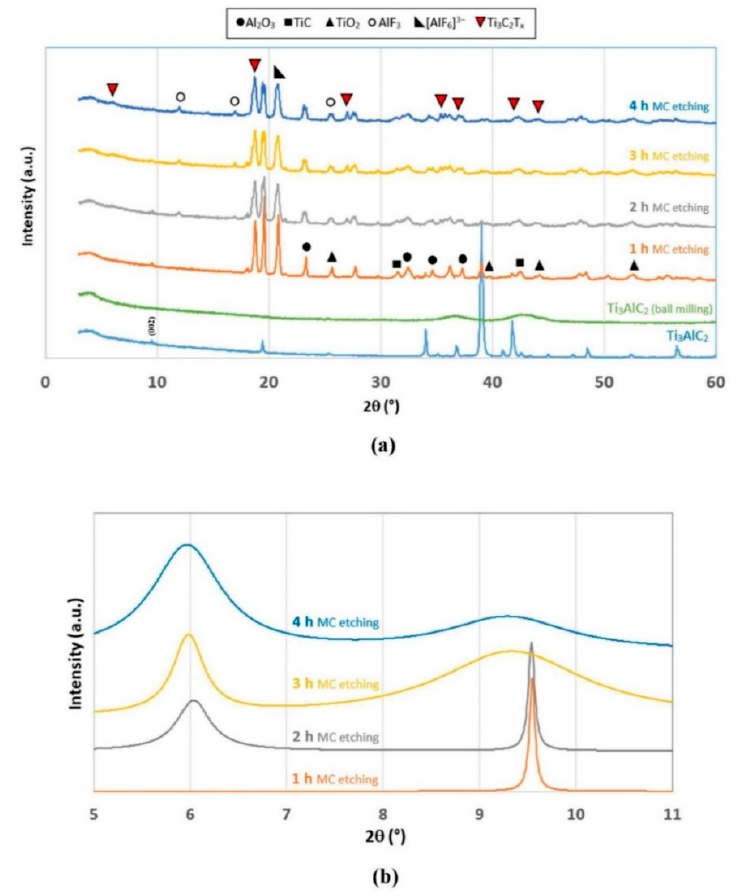
Figure 2. ( a ) Di ff ractograms of mechanochemical (MC) etching with HF at di ff erent milling times. Figure 2. ( a ) Diffractograms of mechanochemical (MC) etching with HF at different milling times. ( b ) ( b ) Rietveld refinement of XRD peak of Rietveld refinement of XRD peak of (002).